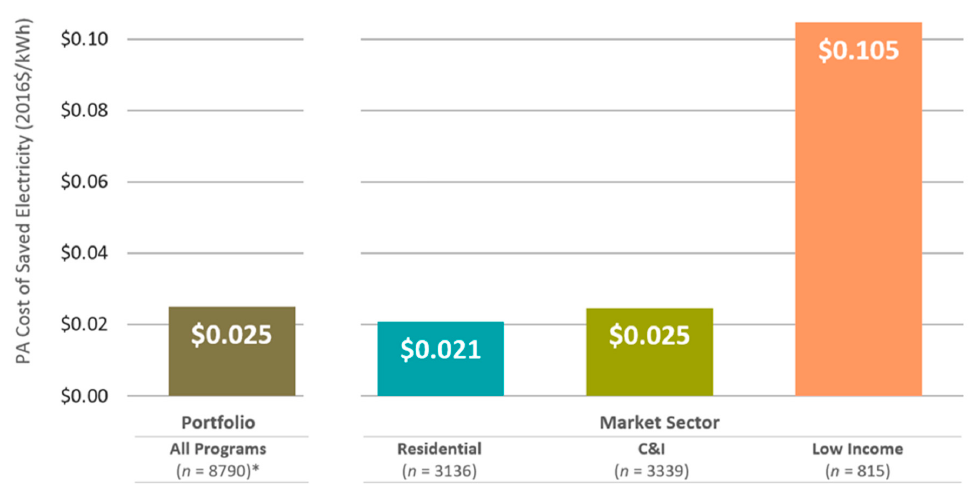
Figure 3. Program administrator CSE for electricity efficiency programs by market sector as national savings-weighted averages. * The sample size for the full portfolio included programs for which savings were not claimed but that supported the efficiency activities of the program administrator (e.g., planning, research, and evaluation). The costs for these programs were included in our calculation of the PA CSE at the portfolio and market sector levels. C&I: Commercial and